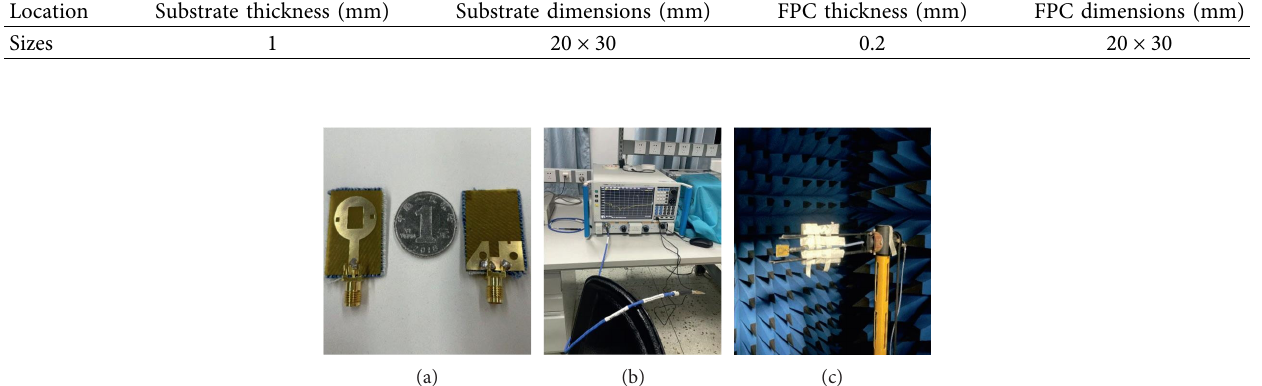
Figure 9: (a) Fabricated textile antenna front and back view. (b) Vector network analyzer. (c) Radiation pattern measured in free space.